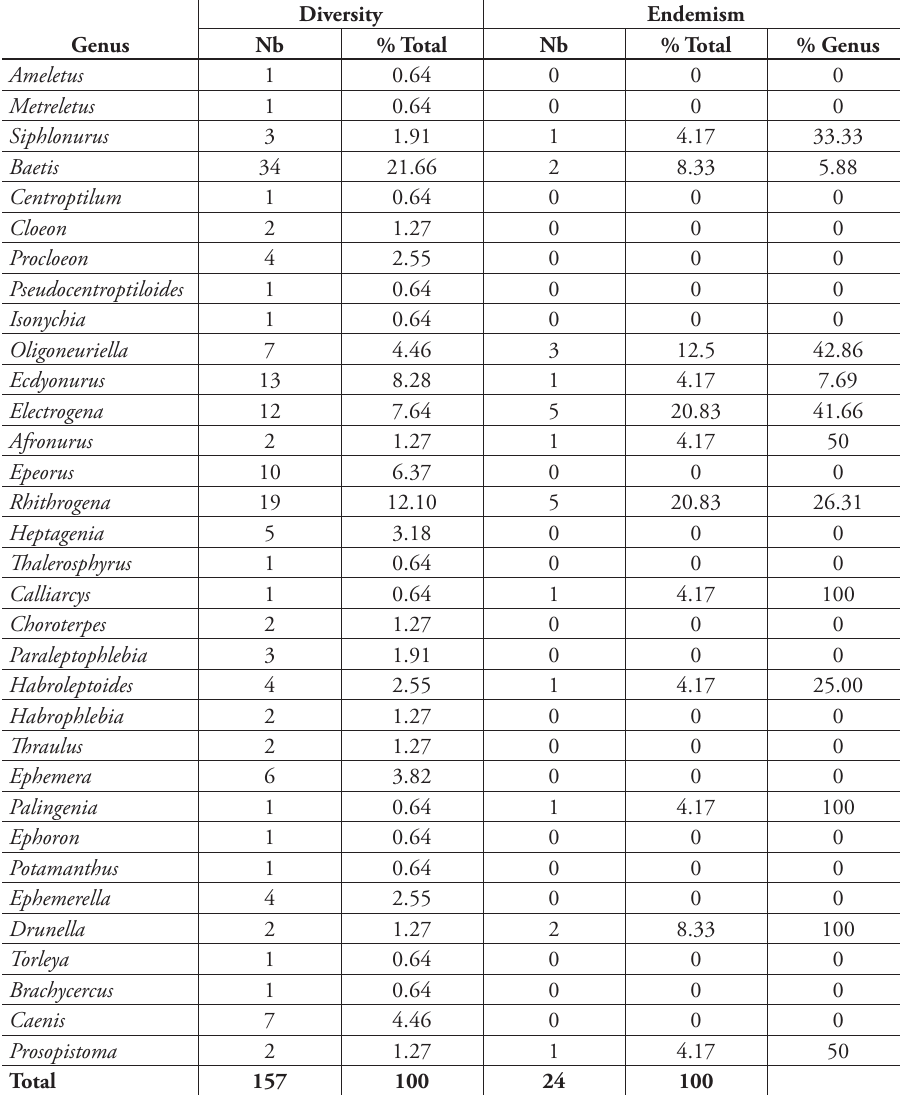
Table 2. Diversity among the different genera occurring in Turkey (Nb = number, % Total = % of total species number, % Genus = % only within the